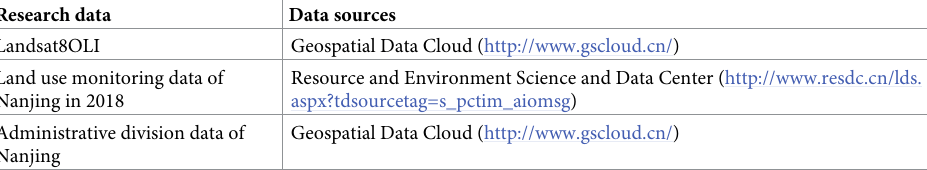
Table 2. Research data and its